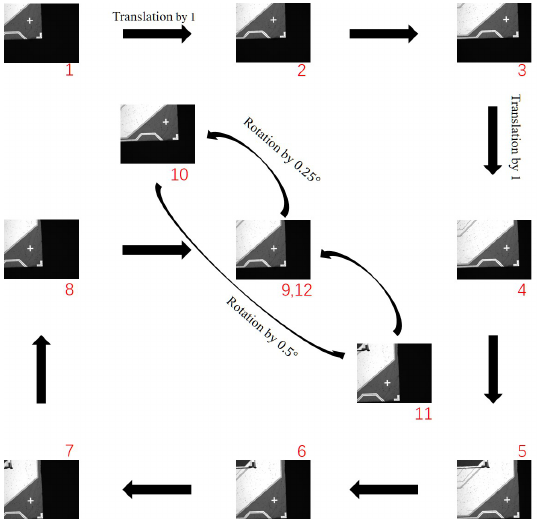
Figure 12. The relationship between the captured images in terms of physical position.